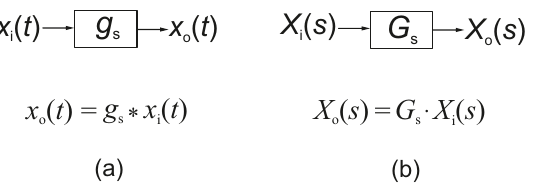
Figure 6. System model of a sensor; (a) in the time domain, (b) in the frequency